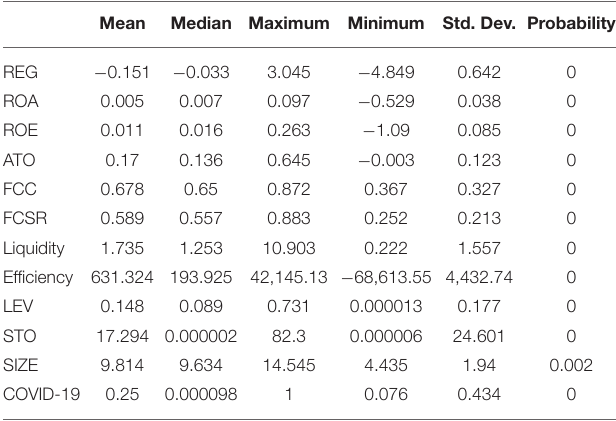
TABLE 2 | Descriptive statistics of variables. Mean Median Maximum Minimum Std. Dev.